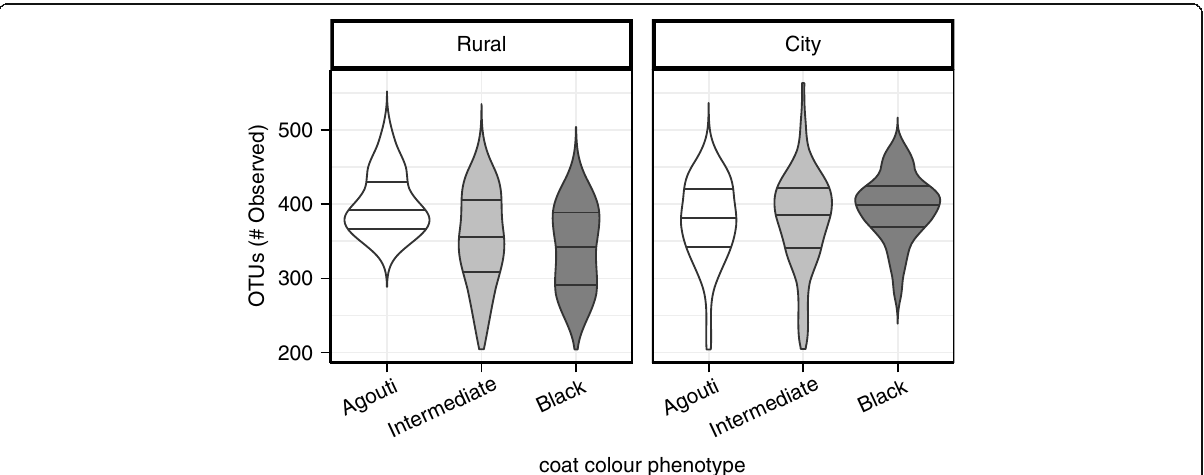
Fig. 2 Bacterial α -diversity in the squirrel microbiome is negatively correlated with melanism at rural sites ( p = 0.02), but positively correlated with melanism among squirrels within city sites ( p < 0.01). Solid horizontal lines within violins denote the interquartile range